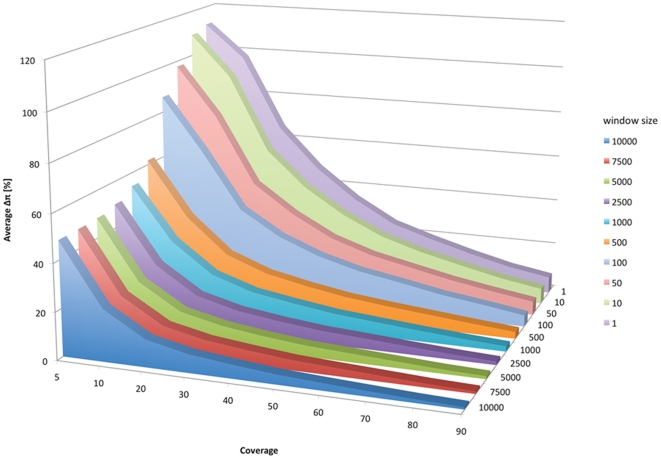
The influence of coverage and window size on the accuracy of the estimated θ
π.The accuracy was measured as the mean standardized difference between θ
π estimated for a given window size and its expectation.